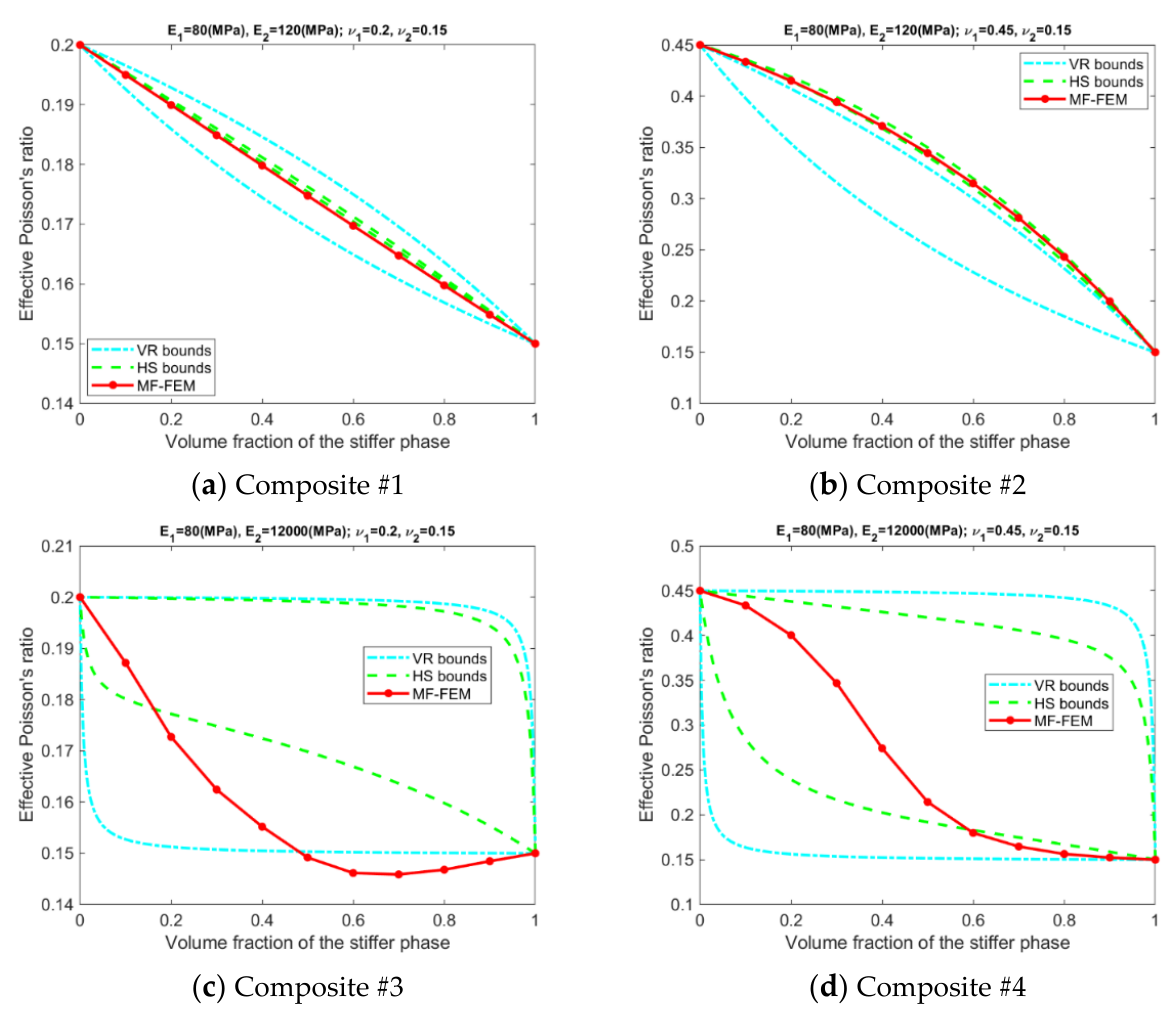
Figure 6. Relation between MF-FEM predictions and VR/HS bounds of effective Poisson’s ratio.